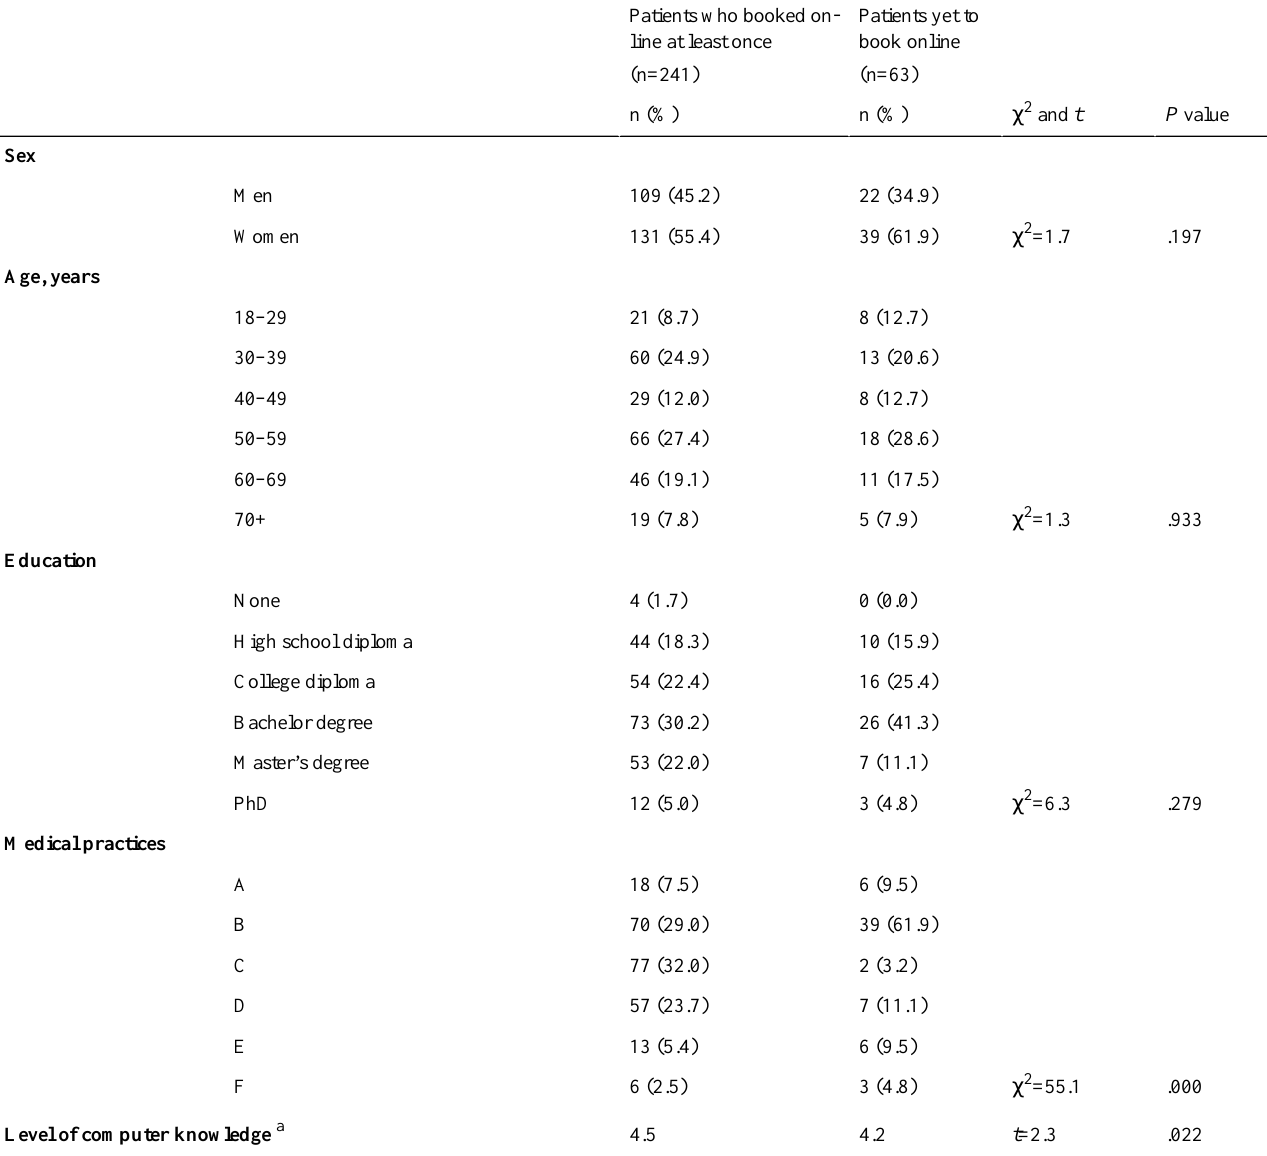
Table 2. Profile of survey respondents (n=304).